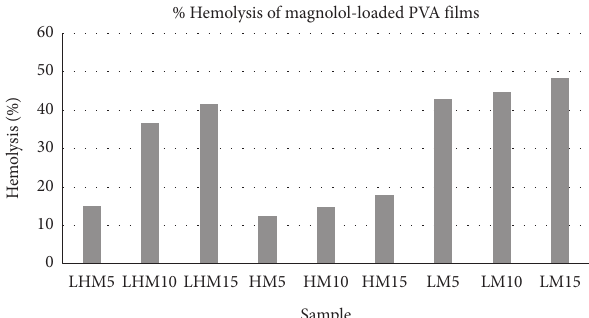
Figure 16: Drug release % of ginger-loaded PVA (H+L) films.